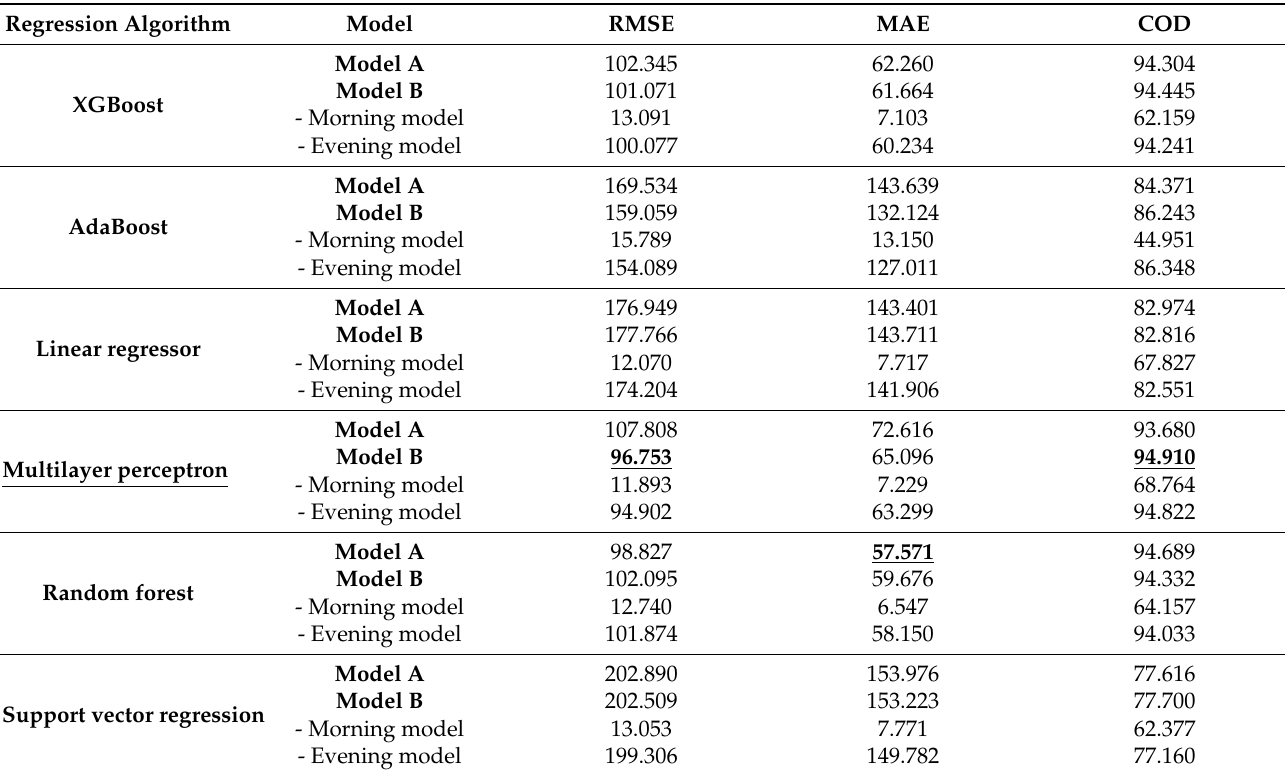
Figure 4. Architecture of the forecasting models. ( a ) Model A architecture. ( b ) Model B architecture. In Model B, the summation of the morning model and the evening model was taken as the final output. Morning and evening models were trained separately without any data sharing. Table 3. Accuracy of models predicting day-ahead EV